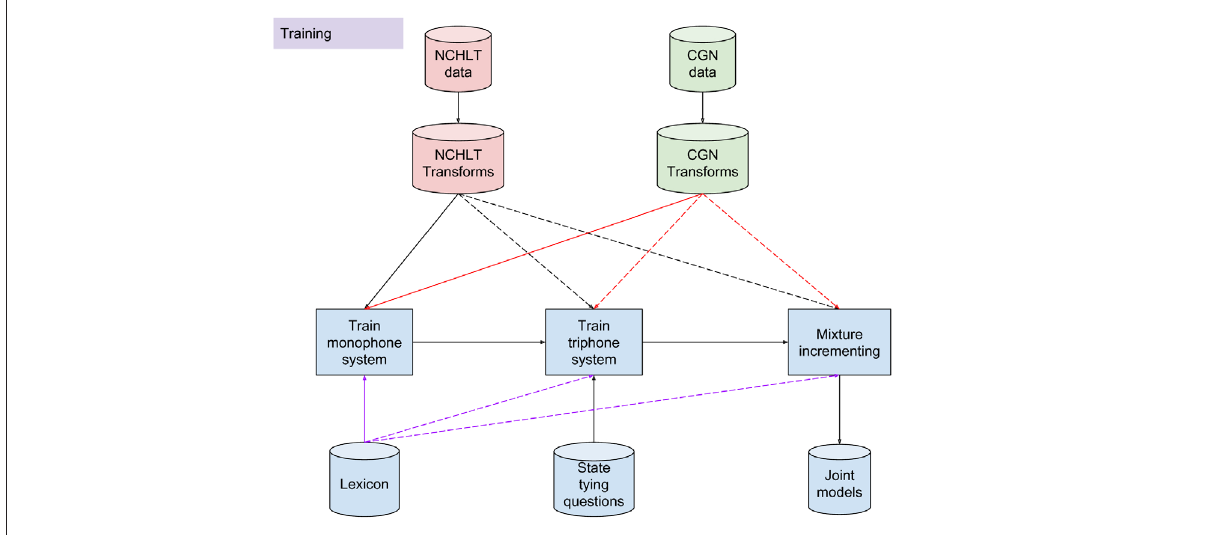
NCHLT, National Centre for Human Language Technology; CGN, Corpus Gesproken Nederlands Figure 3: Retrain using language constrained maximum likelihood linear regression transform training scheme.